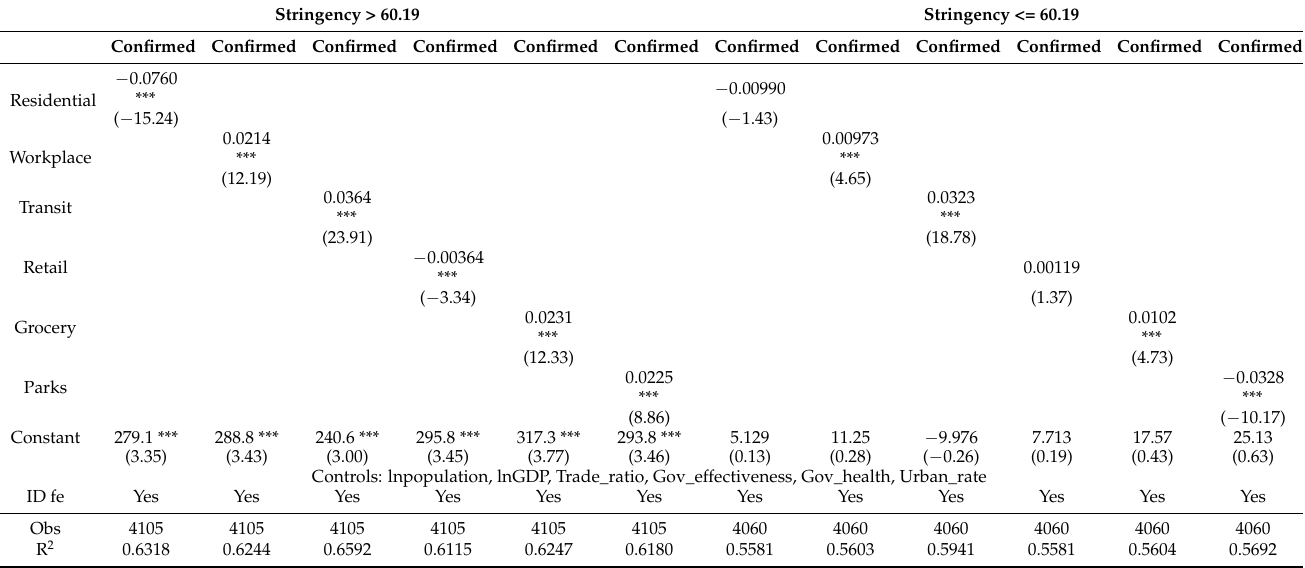
Table 3. Effect of Google mobility on the number of confirmed diagnoses at different levels of stringency. Stringency >